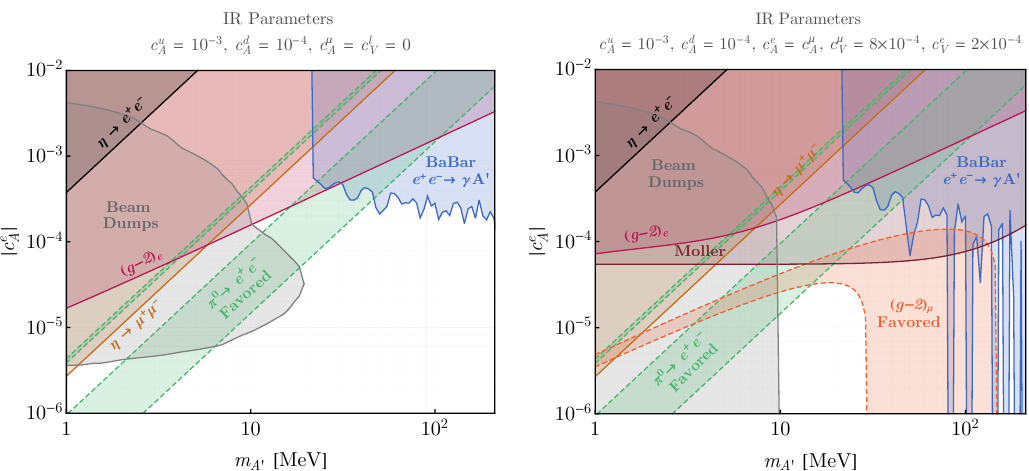
Figure 1 . Parameter space for c e as a function of m A 0 , assuming c u A The left panel assumes all other couplings vanish, while the right panel assumes c e c (cid:22) = 8 (cid:2) 10 (cid:0) 4 , and c (cid:22) = c e . Two regions are compatible with (cid:25) 0 ! e + e (cid:0) , but one of these is A V A ruled out by (cid:17) ! (cid:22) + (cid:22) (cid:0) . Note that specifying a value for c e constraint curves for c e in the right A